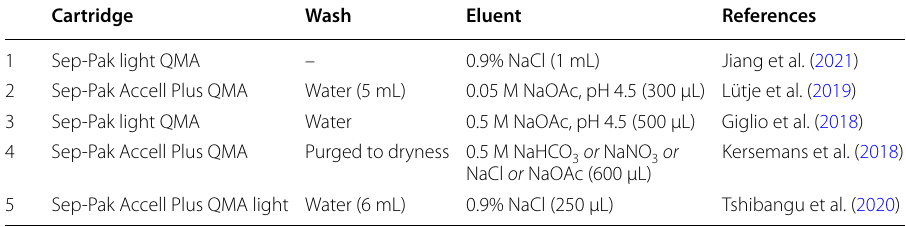
Elution of [ 18 F]F − from a QMA is invariably efficient (ca. 99% recovery) but the choice of eluent can modulate radioactive concentration. This was demonstrated by Kersemans et al. (2018) and may be considered as a parameter for optimisation when developing new [ 18 F]AlF labelling protocols (Kersemans et al.